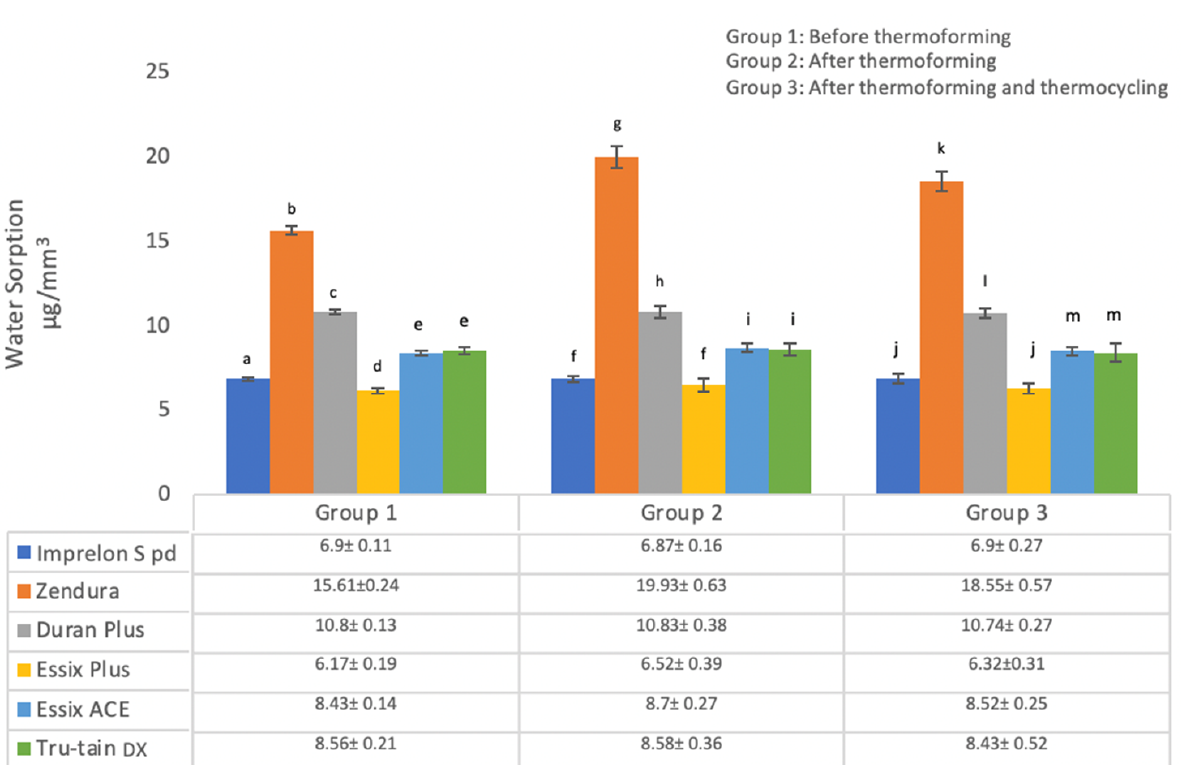
Figure 5. Comparison of the water sorption between the investigated materials. Groups with similar small letters have no significant difference at ( p < 0.05).